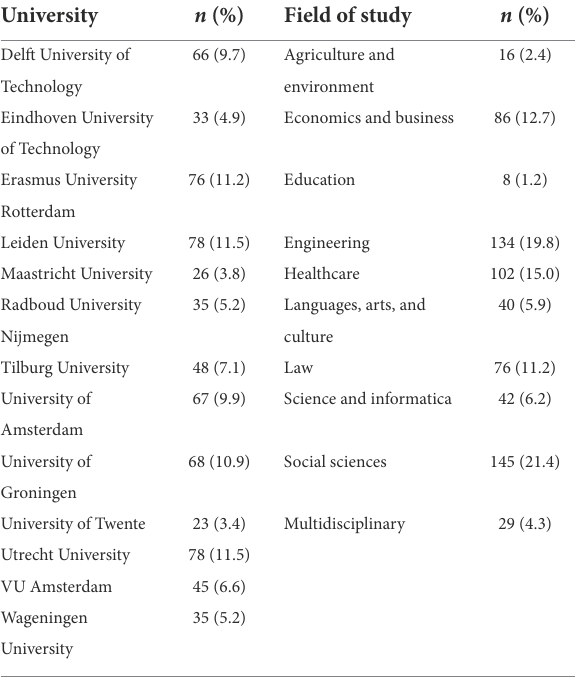
TABLE 1 Study characteristics of the analyzed sample ( N = 678).